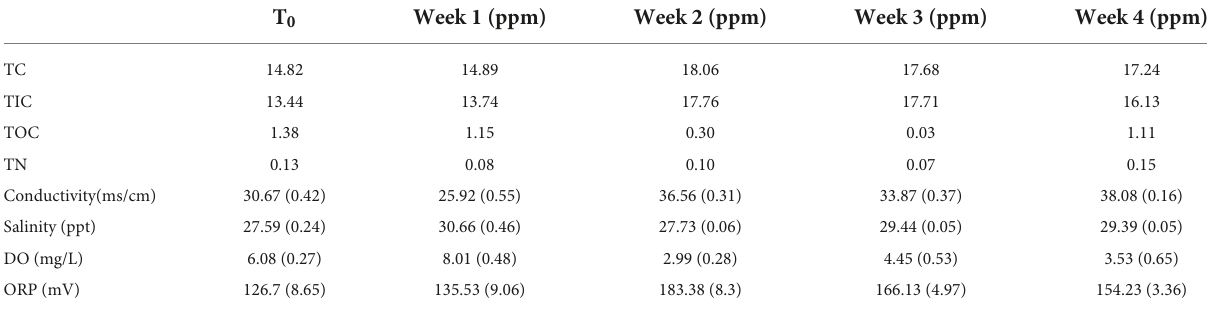
TABLE 3 Carbon and Nitrogen measure taken of the water present in the aquaria at the time of each sampling point.